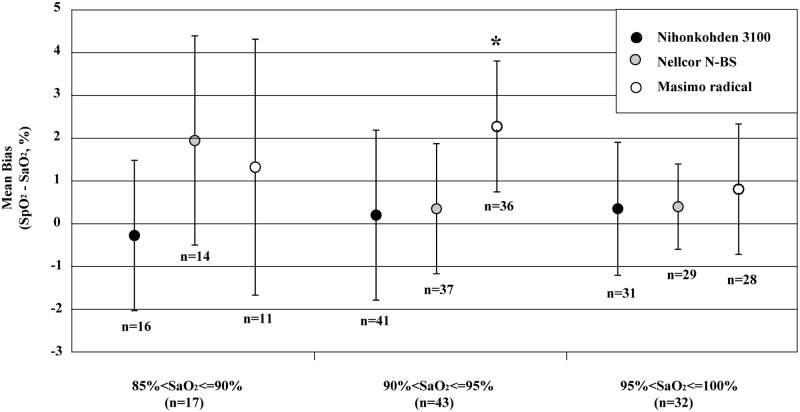
Bias (mean ± SD) for the 3 oximeters in the 5% range of SaO2 (oxyhemoglobin saturation measured by blood gas analyzer [ABL 825]).Bias is calculated as SpO2 (oximeter-measured value of oxyhemoglobin saturation) minus SaO2. SpO2 measured by Nihonkohden 3100 are indicated with closed circles, SpO2 by Nellcor N-BS with gray circles, and SpO2 by Masimo radical with open circles. Data are presented as the mean ± SD and analyzed by one-way analysis of variance followed by Tukey’s test: * p<0.0001 vs. Nihonkohden 3100 and Nellcor N-BS.